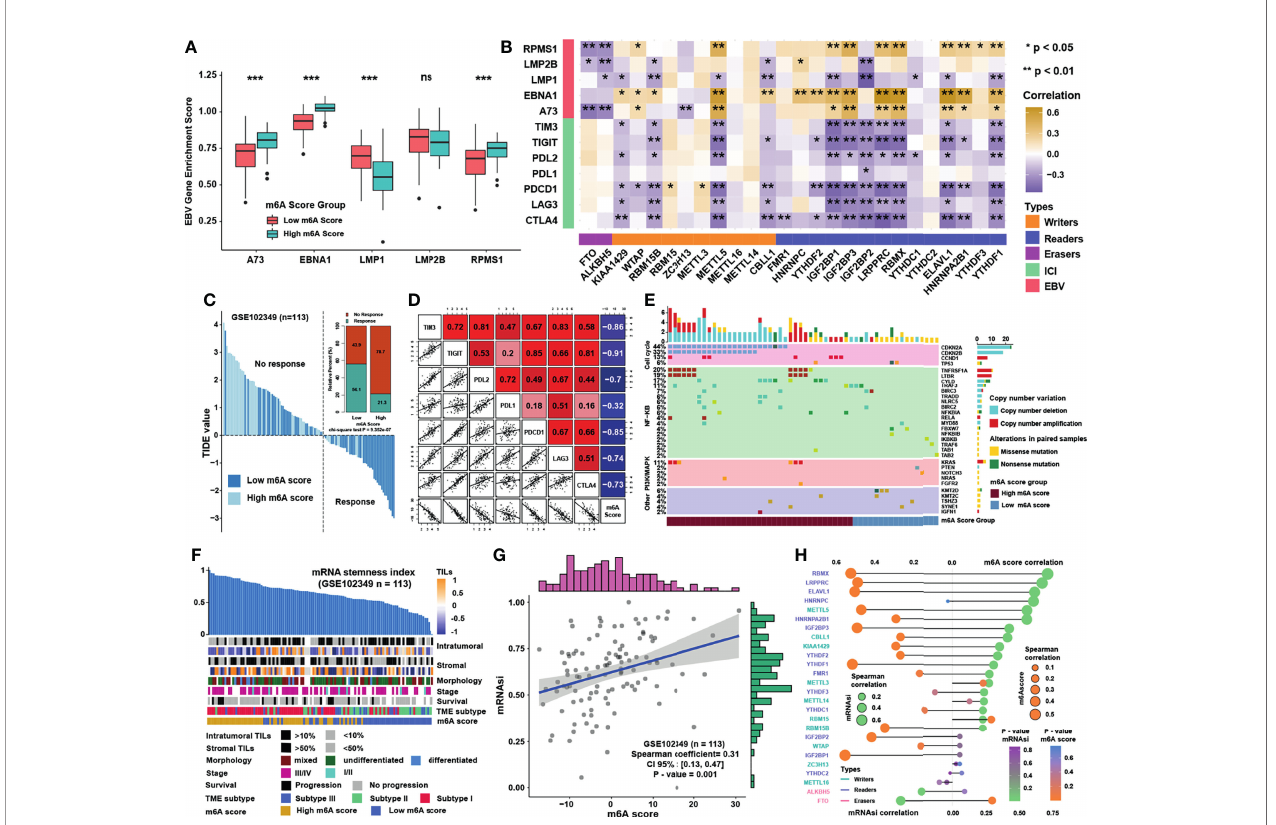
FIGURE 7 | Characteristics and biological functions of m6A score in NPC. (A) The abundance of EBV gene enrichment score in m6A score groups. (B) Correlations between m6A regulators and immune checkpoint molecules and EBV gene GSVA score in GSE102349 using Spearman analysis. (C) TIDE value of NPC samples in GSE102349 was shown in different m6A score groups and the chi-square test was used to calculate statistical differences. (D) Correlation analysis of m6A score and immune checkpoint inhibitors. (E) Mutation and somatic copy number variations for the paired NPC cohort in GSE102349 and m6A score groups for each patient. (F) An overview of the association between known clinical and molecular features and mRNAsi in NPC. Columns represented samples sorted by mRNAsi from low to high (top row). Rows represented known clinical and molecular features. (G) Correlation analysis between mRNAsi and m6A score using Spearman analysis. (H) Correlation analysis between mRNAsi and m6A score and m6A regulators using Spearman analysis. The dot size represented the correlation level, and the color represented P-value. *P < 0.05; **P < 0.01; ***P < 0.001; ns, no signi fi